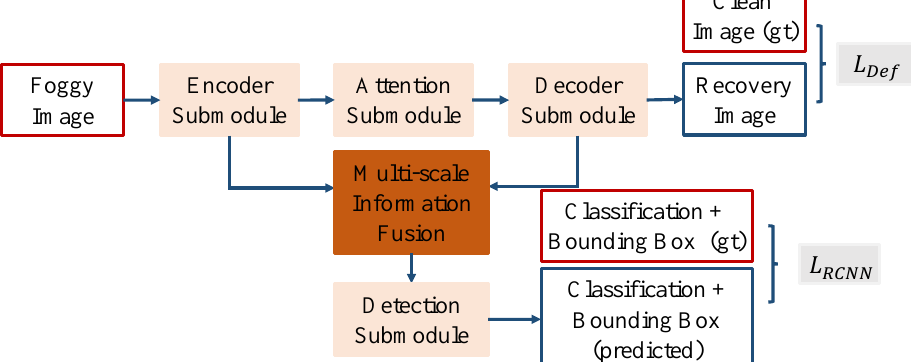
Figure 1. The idea of our proposed algorithm. The red boxes represent the inputs, the blue boxes represent the outputs, the pink blocks represent the submodules, the orange–red block represents the information fusion by element-wise addition, and the grey blocks represent the objective functions, which are defined in accordance with Equations (1) and (3) in the following